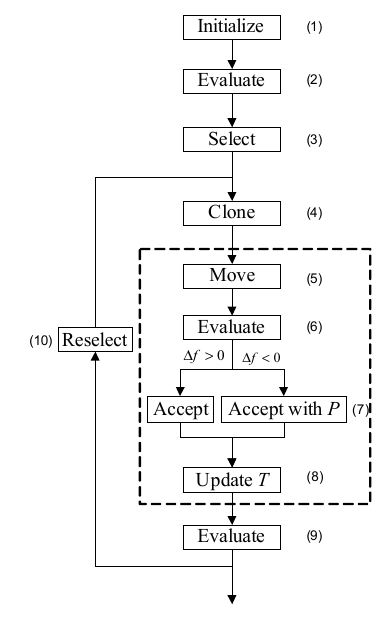
Fig. 3. Flow chart of hybrid optimization